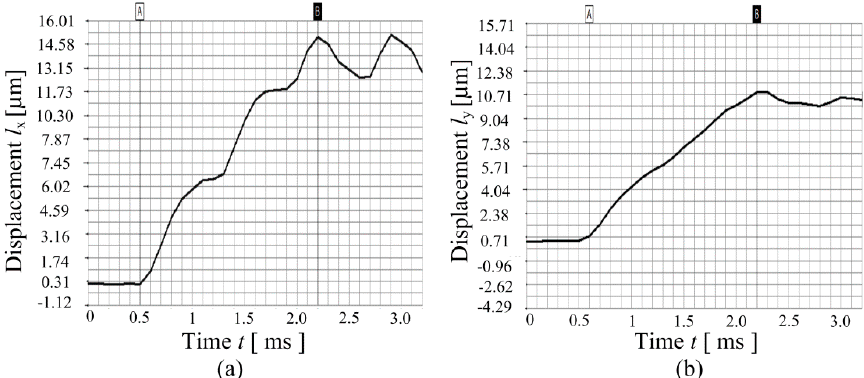
Figure 11. Step response of the proposed 2-DOF platform: ( a ) x -stage; ( b ) y -stage.